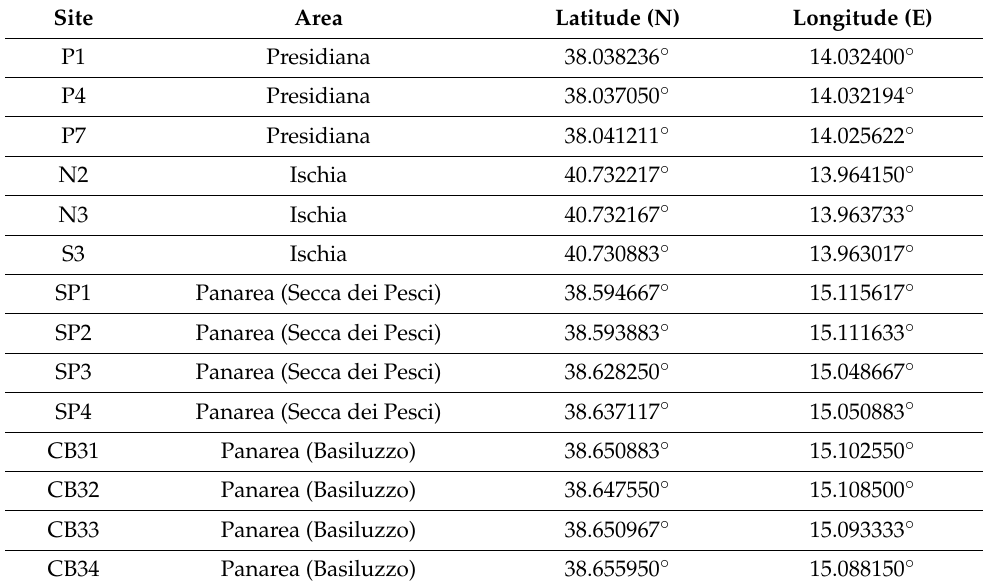
Table 1. Sampling site coordinates and